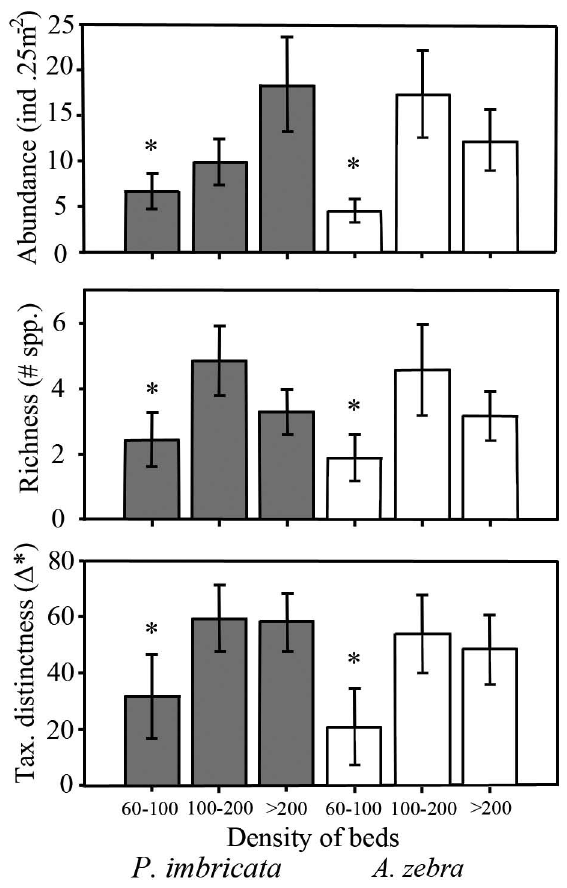
Fig . 1. – Abundance, richness and taxonomic distinctness of deca- pod crustaceans in beds of oyster ( Pinctada imbricata ) and turkey wing ( Arca zebra ) at different densities.